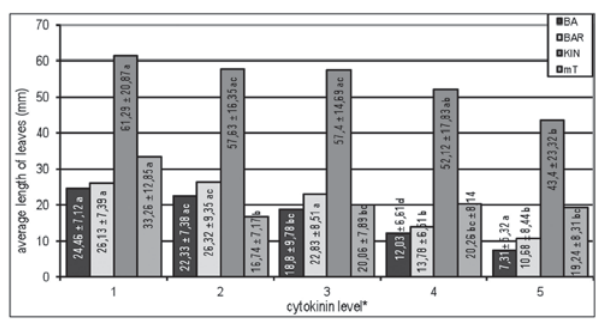
Figure 5. Length of shoots of in vitro Nidularium ’Kertész Jubileum’ plants cultured on different kind of medium (*cytokinin levels were shown on Table 1